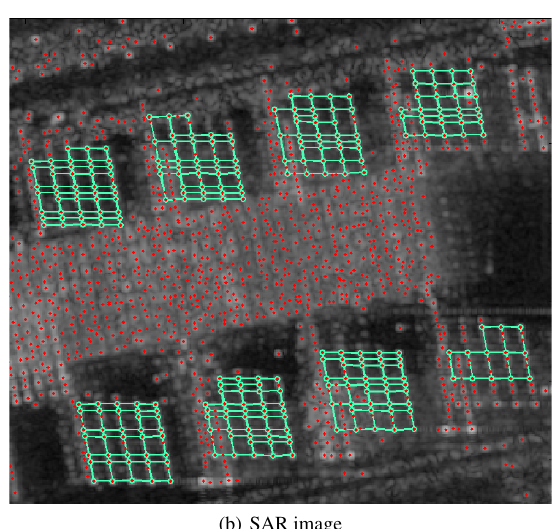
Figure 5: The Paul-L¨obe-Haus in Berlin. The roof consits of con- crete and glass. The resulting PS signature appears randomly. No lattice can be extracted. At the facades lattices can be aggregated.